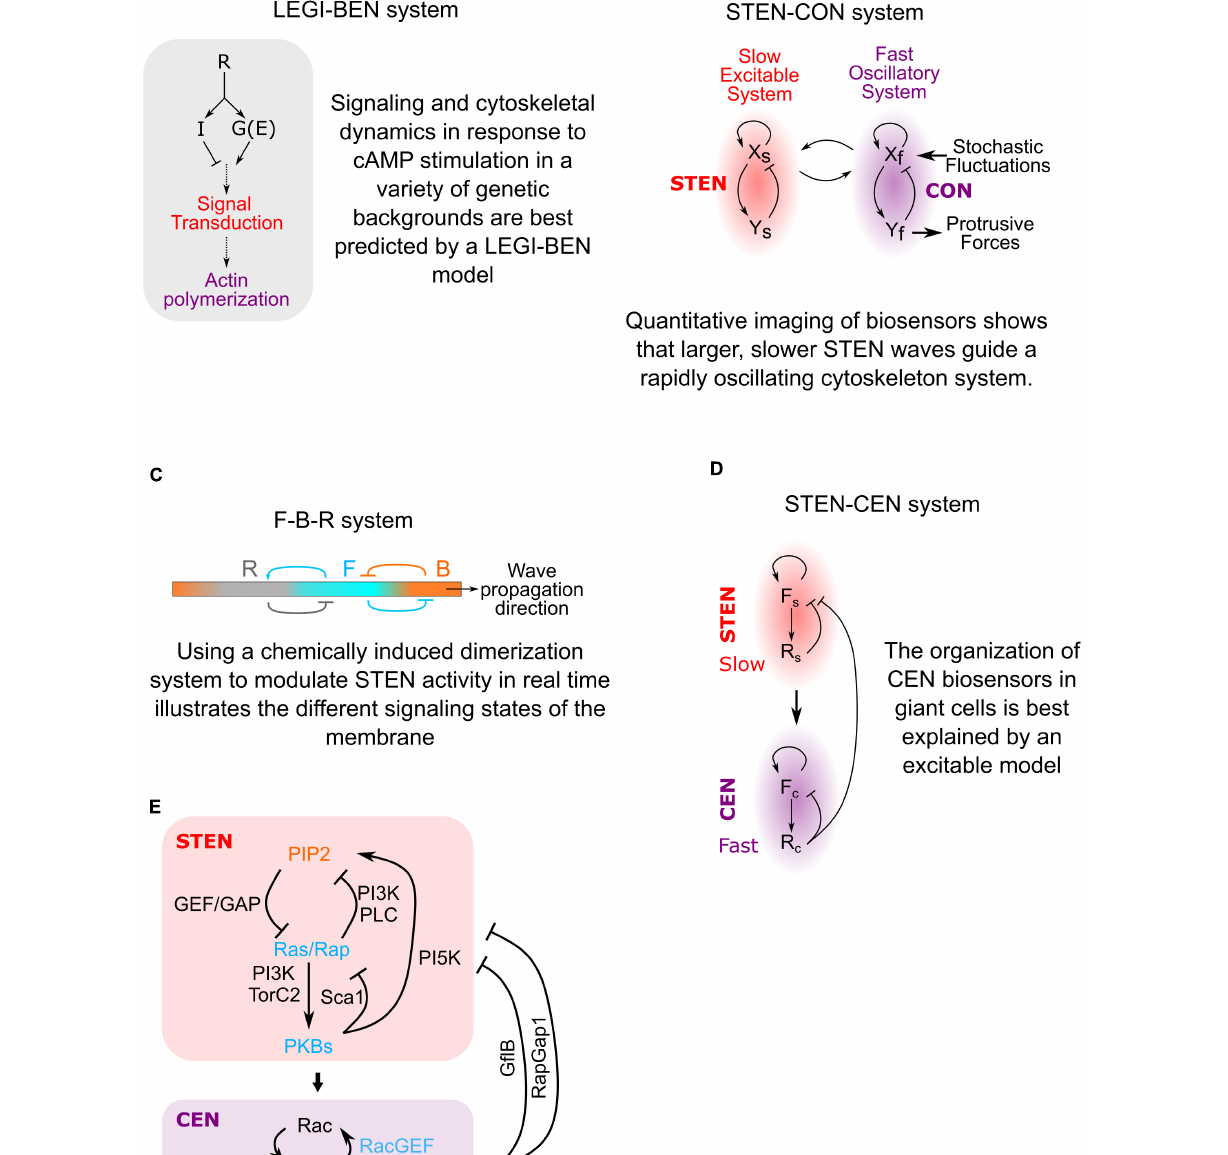
Frontiers in Cell and Developmental Biology |